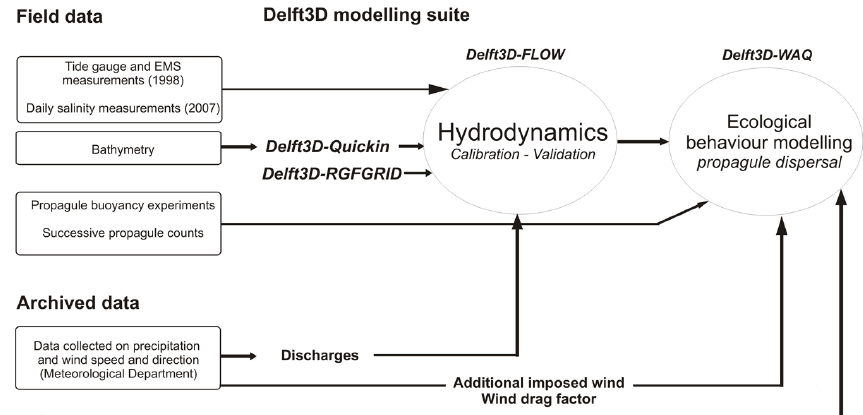
Fig. 2. Overview of the applied